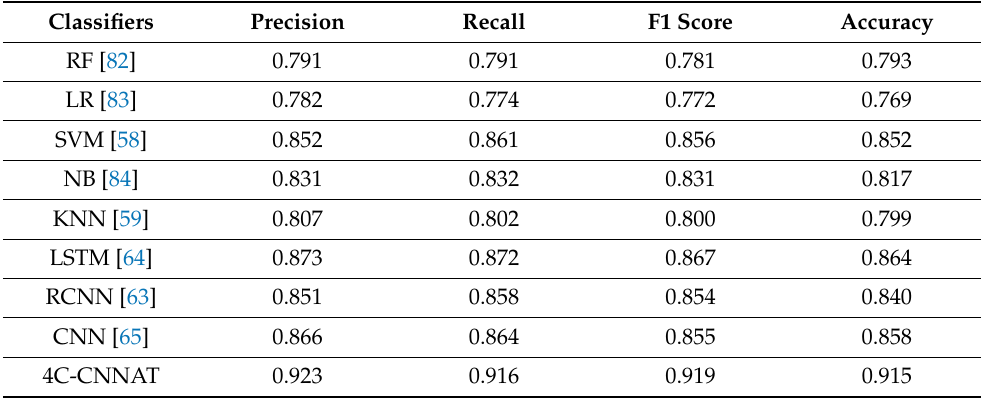
Table 7. 4C-CNNAT performance comparison with various ML/DL classifiers using DRU corpus.